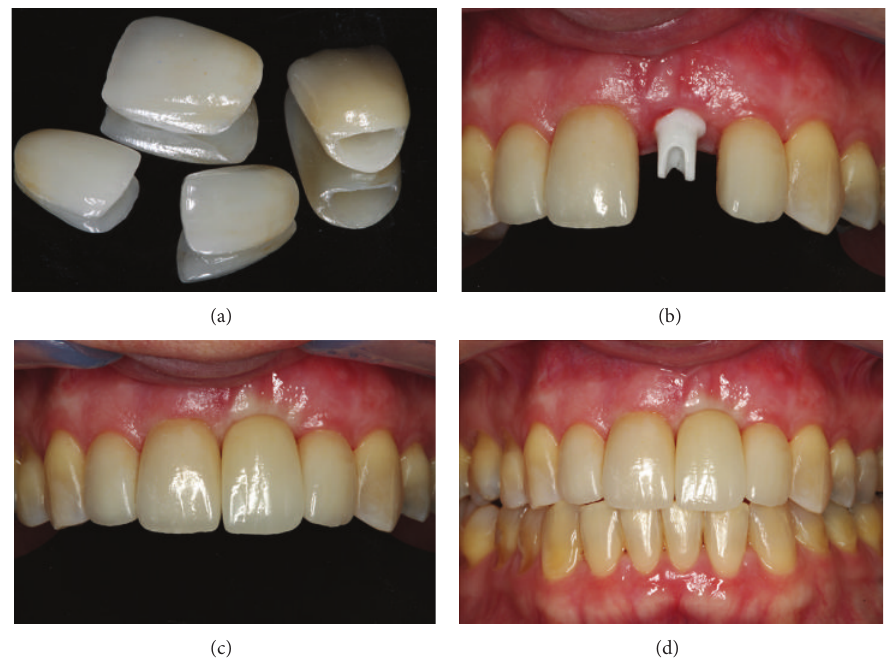
Figure 12: Final prosthesis installed and final result showing excellent aesthetic